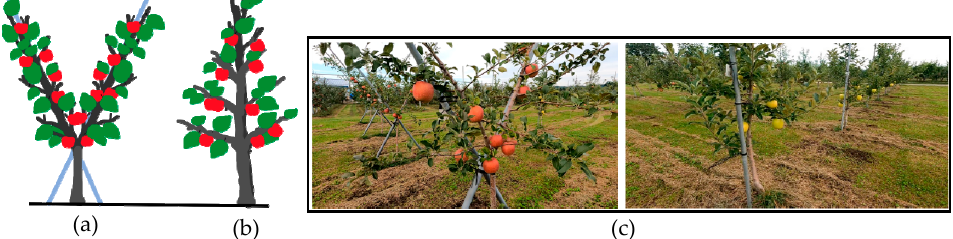
Figure 2. ( a ) V-shaped tree architecture, ( b ) tall spindle tree architecture, and ( c ) V-shape and spindle Figure 2. ( a ) V ‐ shaped tree architecture, ( b ) tall spindle tree architecture, and ( c ) V ‐ shape and architecture in recent orchard practices considering automated spindle architecture in recent orchard practices considering automated system.